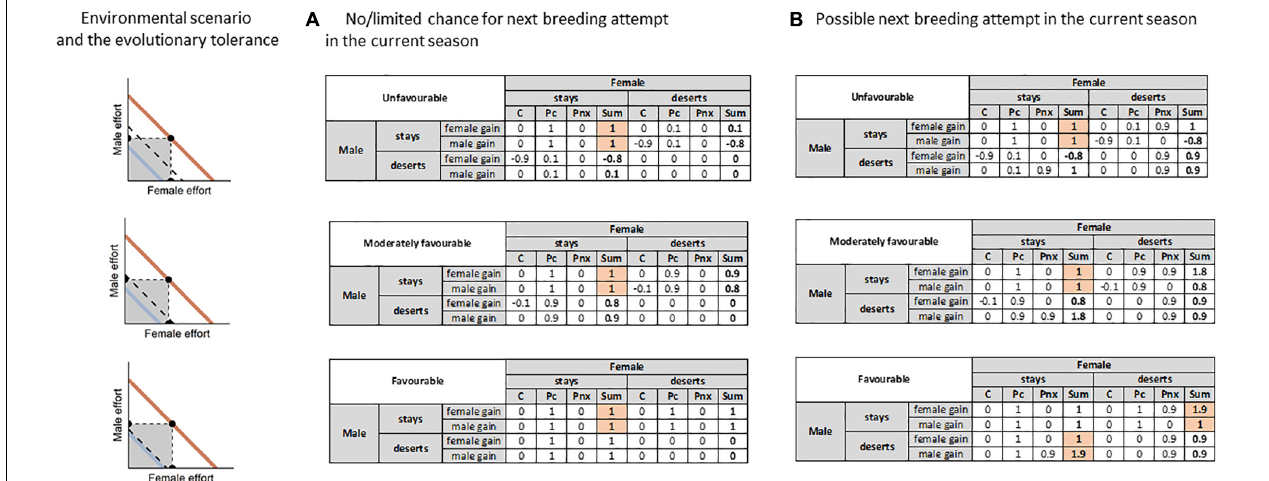
FIGURE 3 | Matrices of males and females reproductive costs and benefits with respect to the mode of parental care and environment quality. The considered environmental quality and the evolutionary tolerance of the species for the environmental quality illustrated on the left panel. Two environmental scenarios are considered: (A) when there is no or only limited chance for successful re-mating in the current season, and (B) when another successful breeding attempt in the current season is possible. C – cost of parental care (see the main text for clarification of this issue) in the current breeding attempt, Pc – probability of the breeding success in the current breeding attempt, Pnx – probability of the breeding success in another breeding attempt in the same breeding season, Sum – outcome of cost and benefits; the sum of the three components: C, Pc, Pnx. The outcome likely to be promoted by selection marked in red. See the main text for a detailed description and